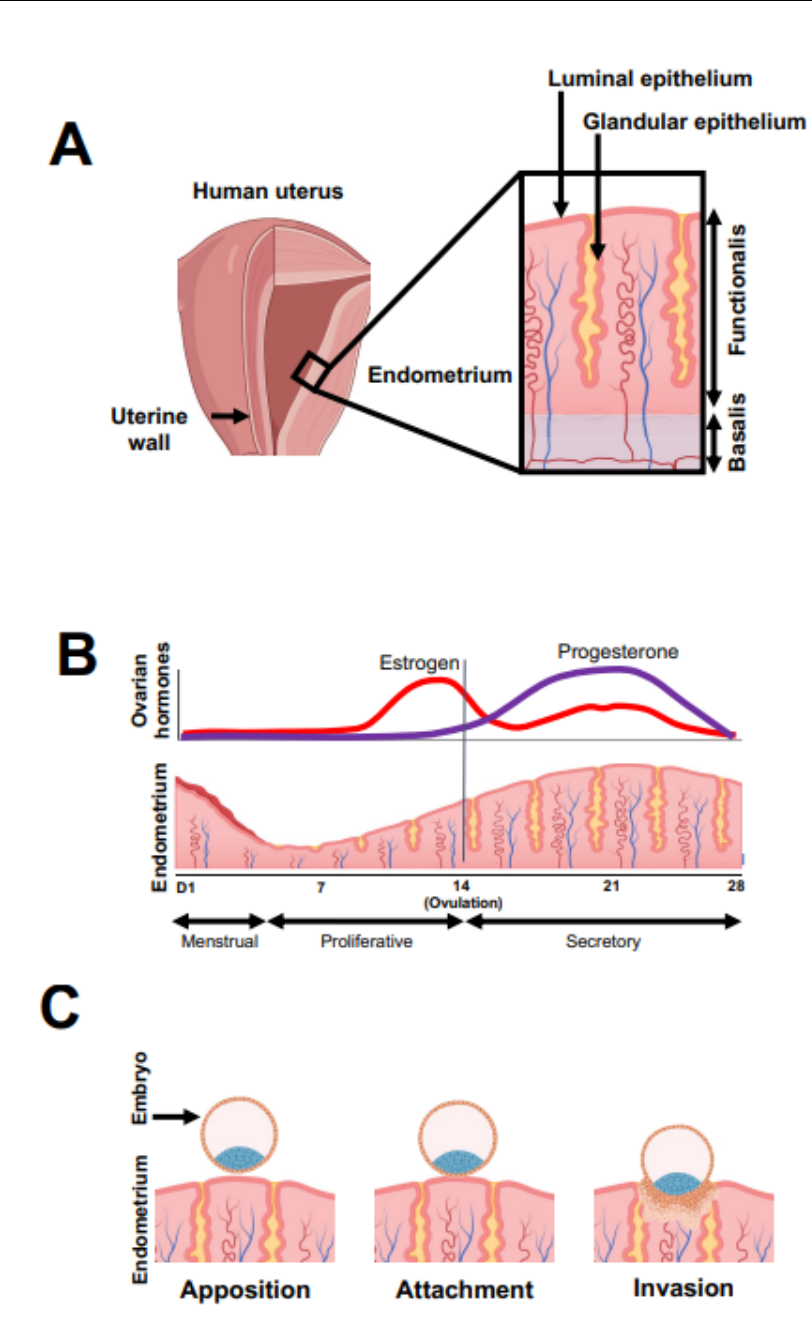
Figure 1. Schematic illustration of the human endometrium, its changes across the menstrual cycle and the initial process of embryo implantation. ( A ) The endometrium, the inner lining of the uterus, consists of the basalis and the functionalis and contains multiple cell types including luminal and glandular epithelial cells. ( B ) Endometrial changes across the menstrual cycle. The menstrual phase, lasting 1–5 days depending on the individual, marks the start of the cycle. The endometrium regrows in the proliferative phase and differentiates in the secretory phase. The fall in progesterone triggers the initiation of menses and the next cycle. ( C ) The apposition, attachment and invasion steps of embryo implantation. The embryo loosely apposes and then firmly attaches to the endometrial luminal epithelium; it then invades the stroma. Created with